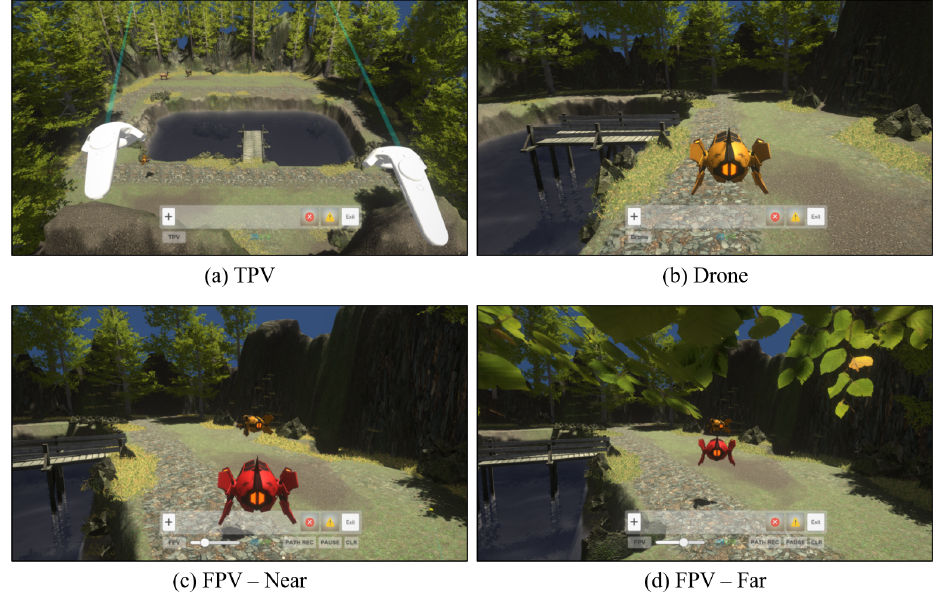
Figure 16. Switching the remote expert’s perspective using ex-STnAD interface: ( a ) TPV; ( b ) drone view; ( c ) FPV close to the virtual drone; ( d ) FPV far from the virtual